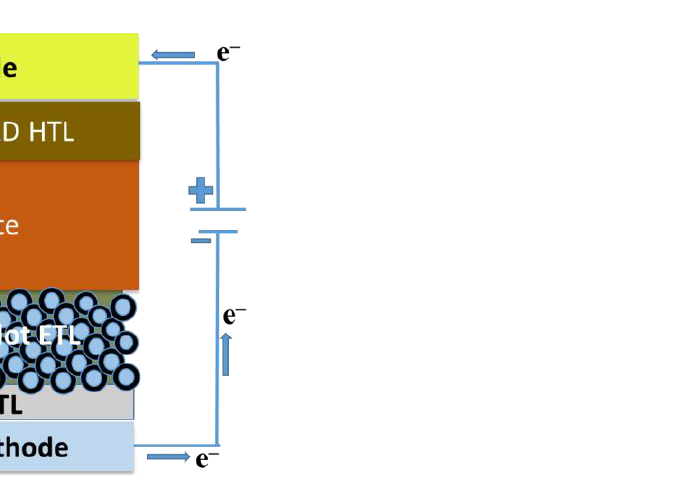
Scheme 1. Scheme of a perovskite solar cell device with a structure of FTO/c-TiO 2 /meso-